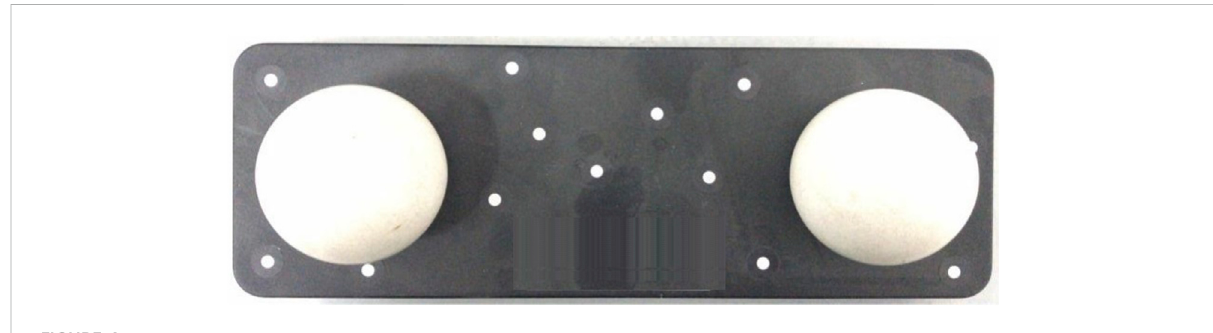
FIGURE 4 High-precision ball bar.